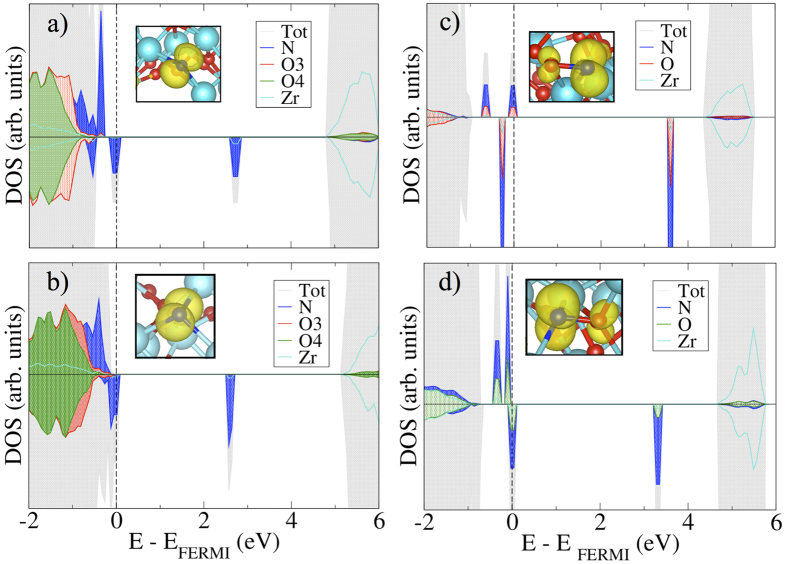
Total and Projected Densities of States of the N-doped structures.(a) Nsub3c -ZrO2; (b) Nsub4c -ZrO2; (c) Nint3c -ZrO2 and (d) Nint4c -ZrO2. Grey line represents TDOS, blue N atom, light blue Zr, red and green O3c and O4c, respectively. The insets show the spin density plots (isodensity threshold values 0.007). The Fermi level is set to the highest occupied level (dashed line).